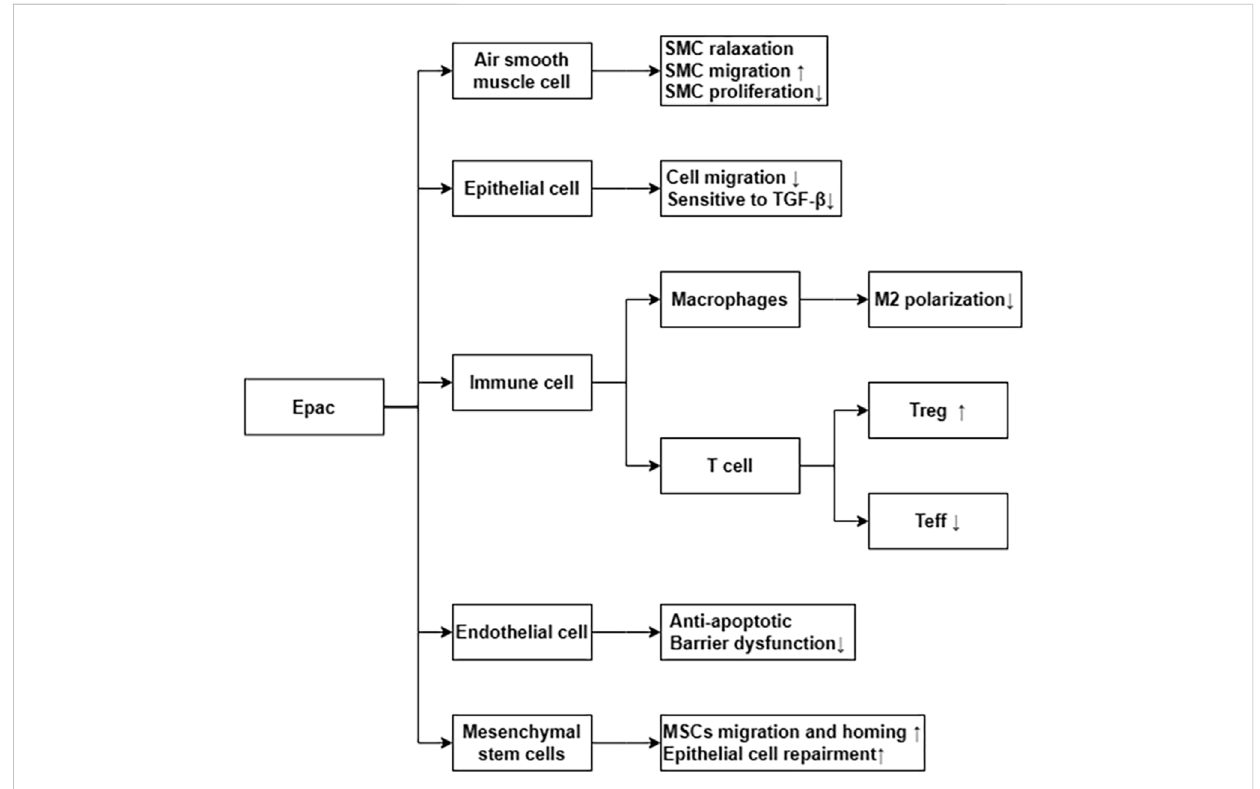
Epac via differential cellular pathways inhibit the process of IPF. ↑ means increase or upregulated; ↓ means decrease or